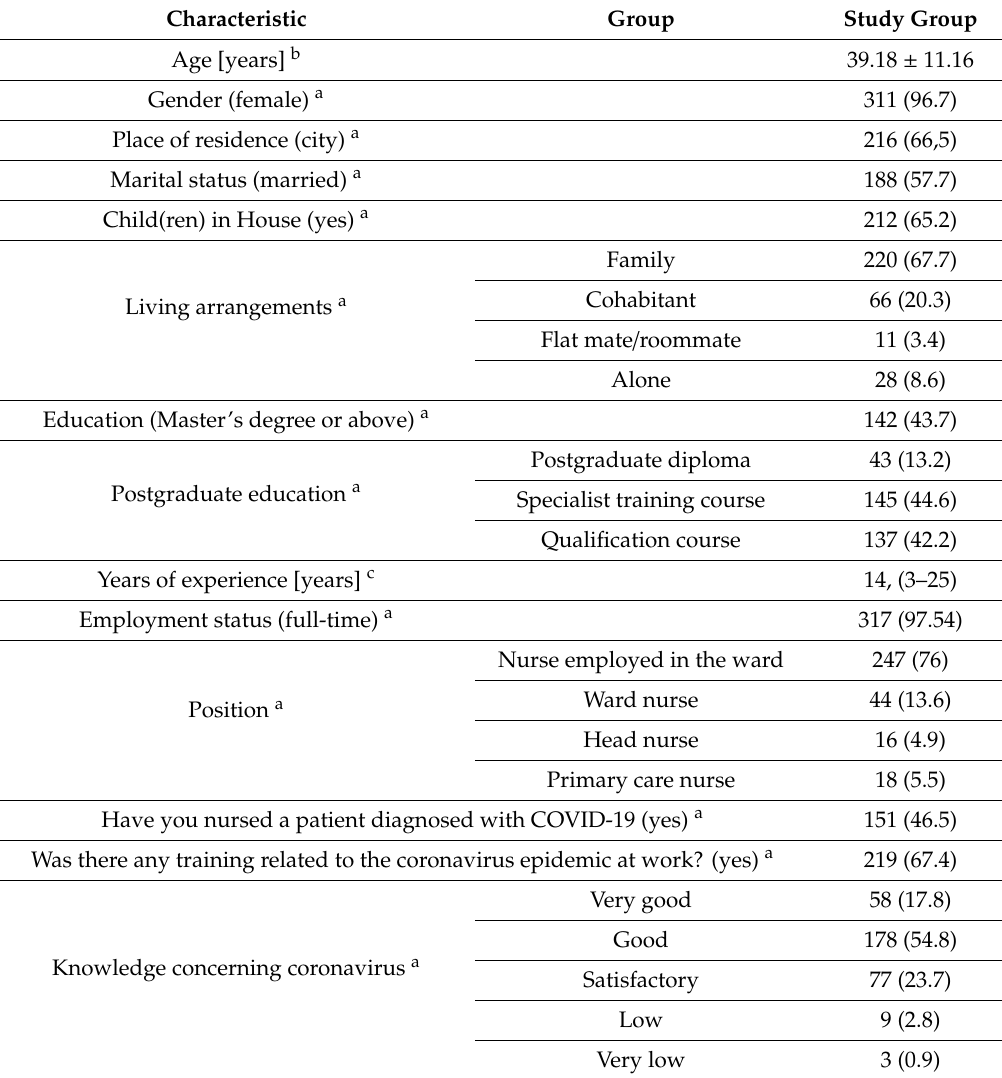
Table 1. Descriptive statistics of surveyed respondents ( n =